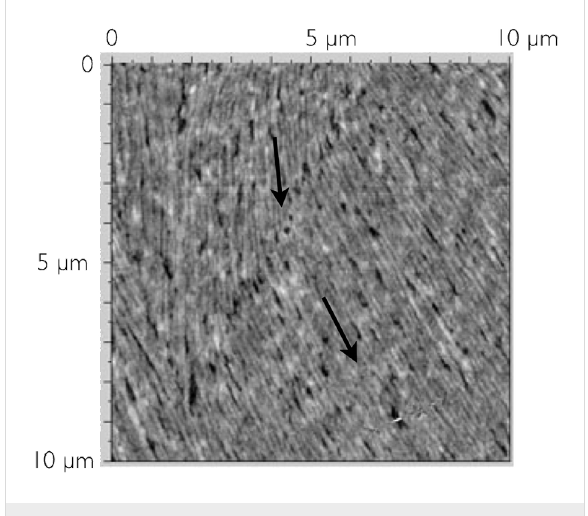
Figure 9: Higher resolution scans of the fiber structure of the low concentration